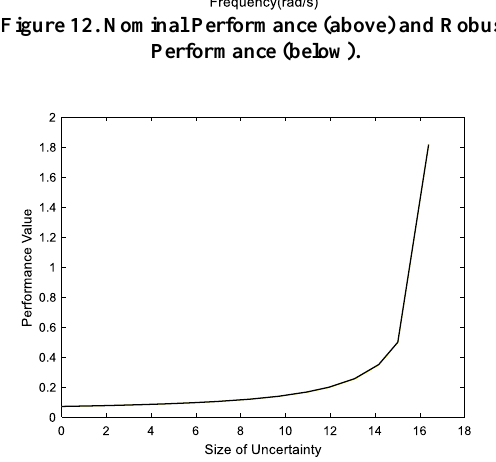
Figure 12. Nominal Performance (above) and Robust Performance (below).